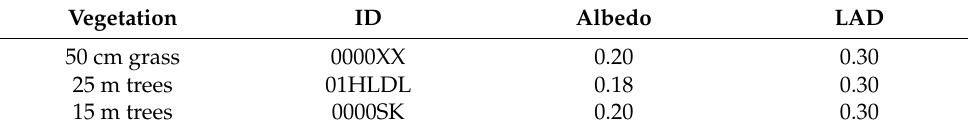
Table 4. Selected physical properties of vegetation (LAD = leaf area density). Vegetation